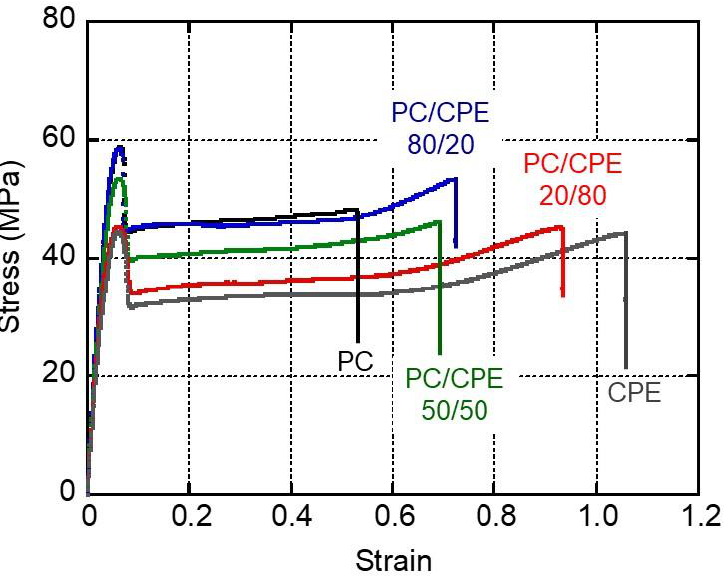
Figure 8. Stress – strain curves of the films. Figure 8. Stress–strain curves of the